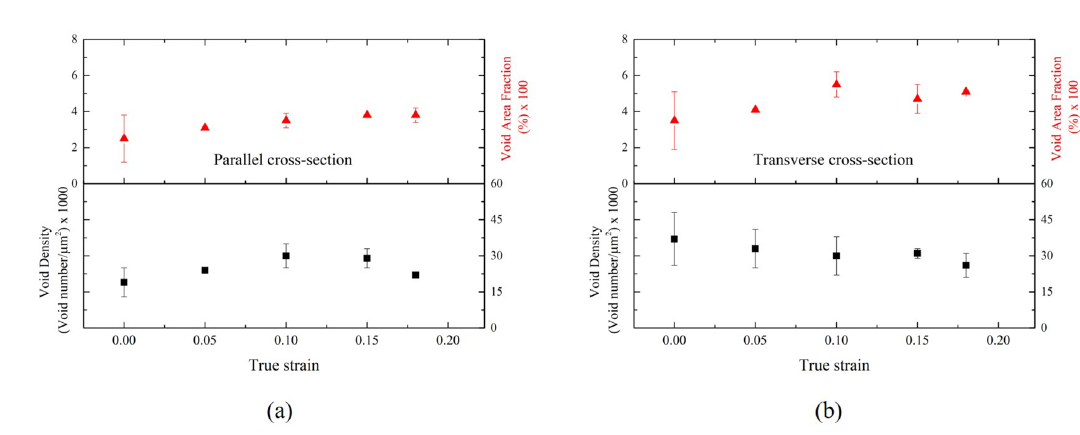
Figure 11. Void density and void area fraction results from the as-received condition and pre-straining levels in uniaxial tension: (a) parallel cross-section and (b) transverse cross-section.